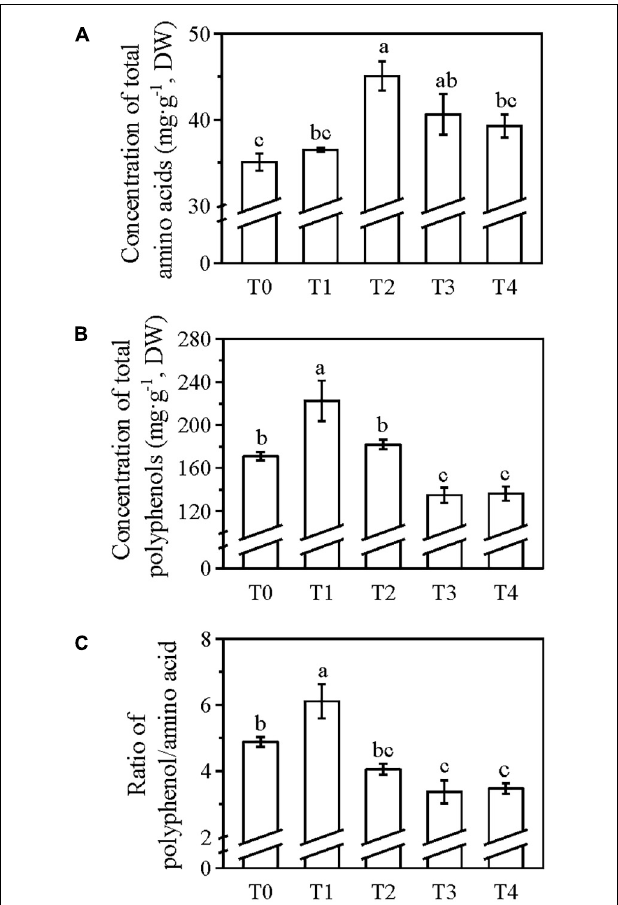
FIGURE 2 | Concentrations of total amino acids (A) , polyphenols (B) , and the polyphenol/amino acid ratio (C) of spring tea from tea plants grown under different application times of foliar N in winter dormancy. A commercially available amino acid liquid fertilizer was applied to the tea plants at T1, T2, T3, or T4; no foliar application of N (T0) was used as control. Values were shown as means ± SEs ( n = 4). Lowercase letters indicated the significant differences ( P < 0.05; ANOVA, followed by the Duncan test). DW, dry